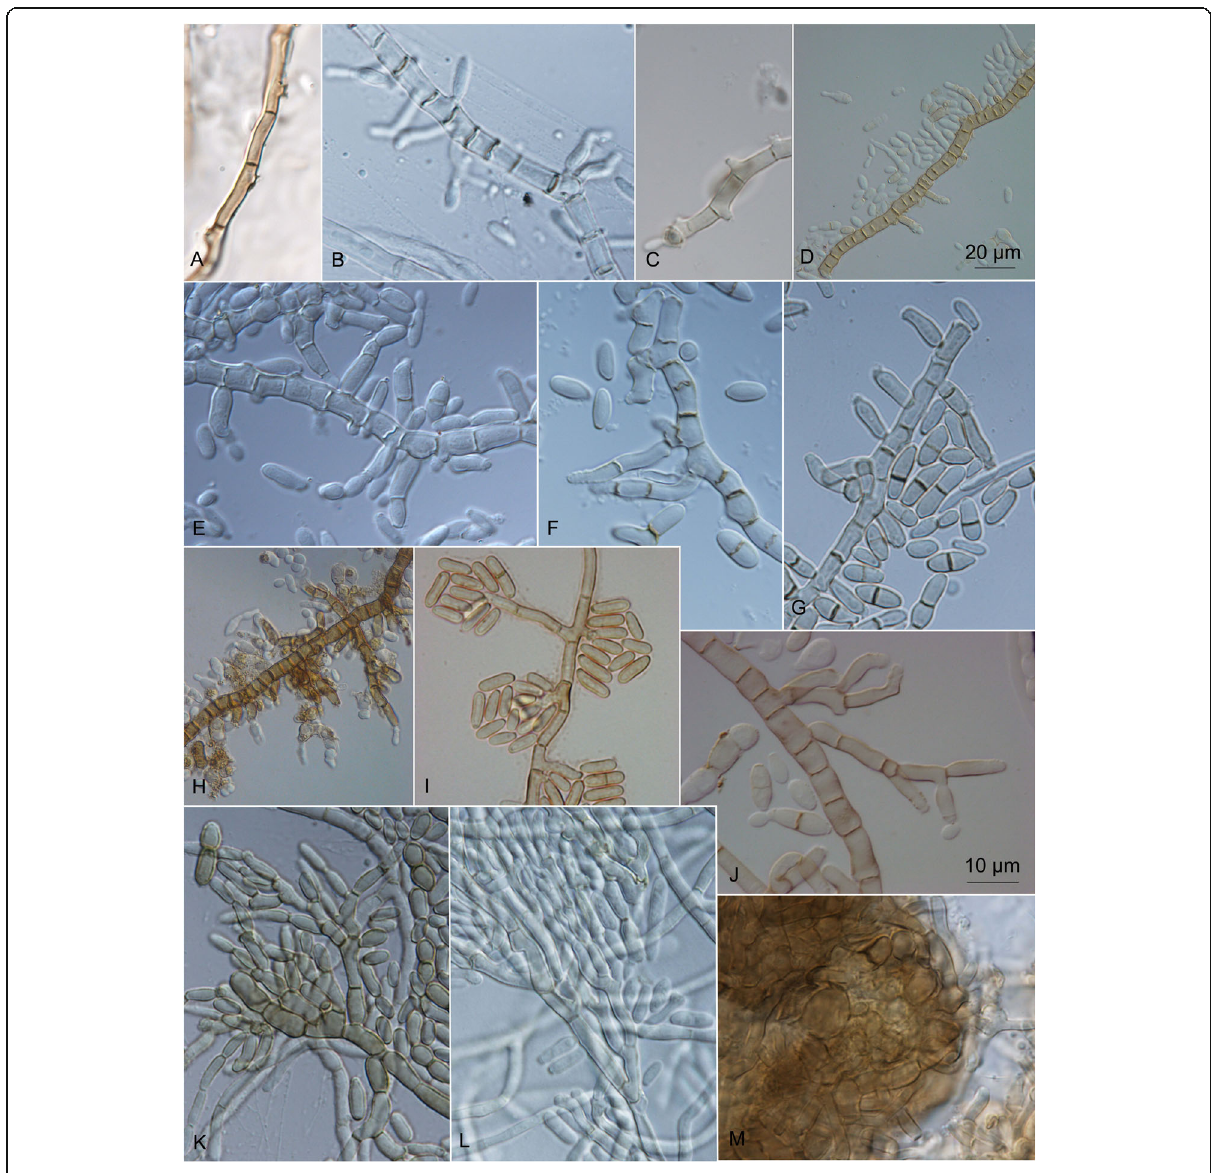
Fig. 12 Sporulating mycelium of Hortaea werneckii strains in cultures after 14 days at 25 °C. a EXF-4493: malt extract agar (MEA), centre. b EXF- 2682: oatmeal agar (OA), margin. c EXF-489: OA. d EXF-647: MEA+ 20% NaCl. e EXF-151: MEA + 10% NaCl. f EXF-2687: OA, centre. g